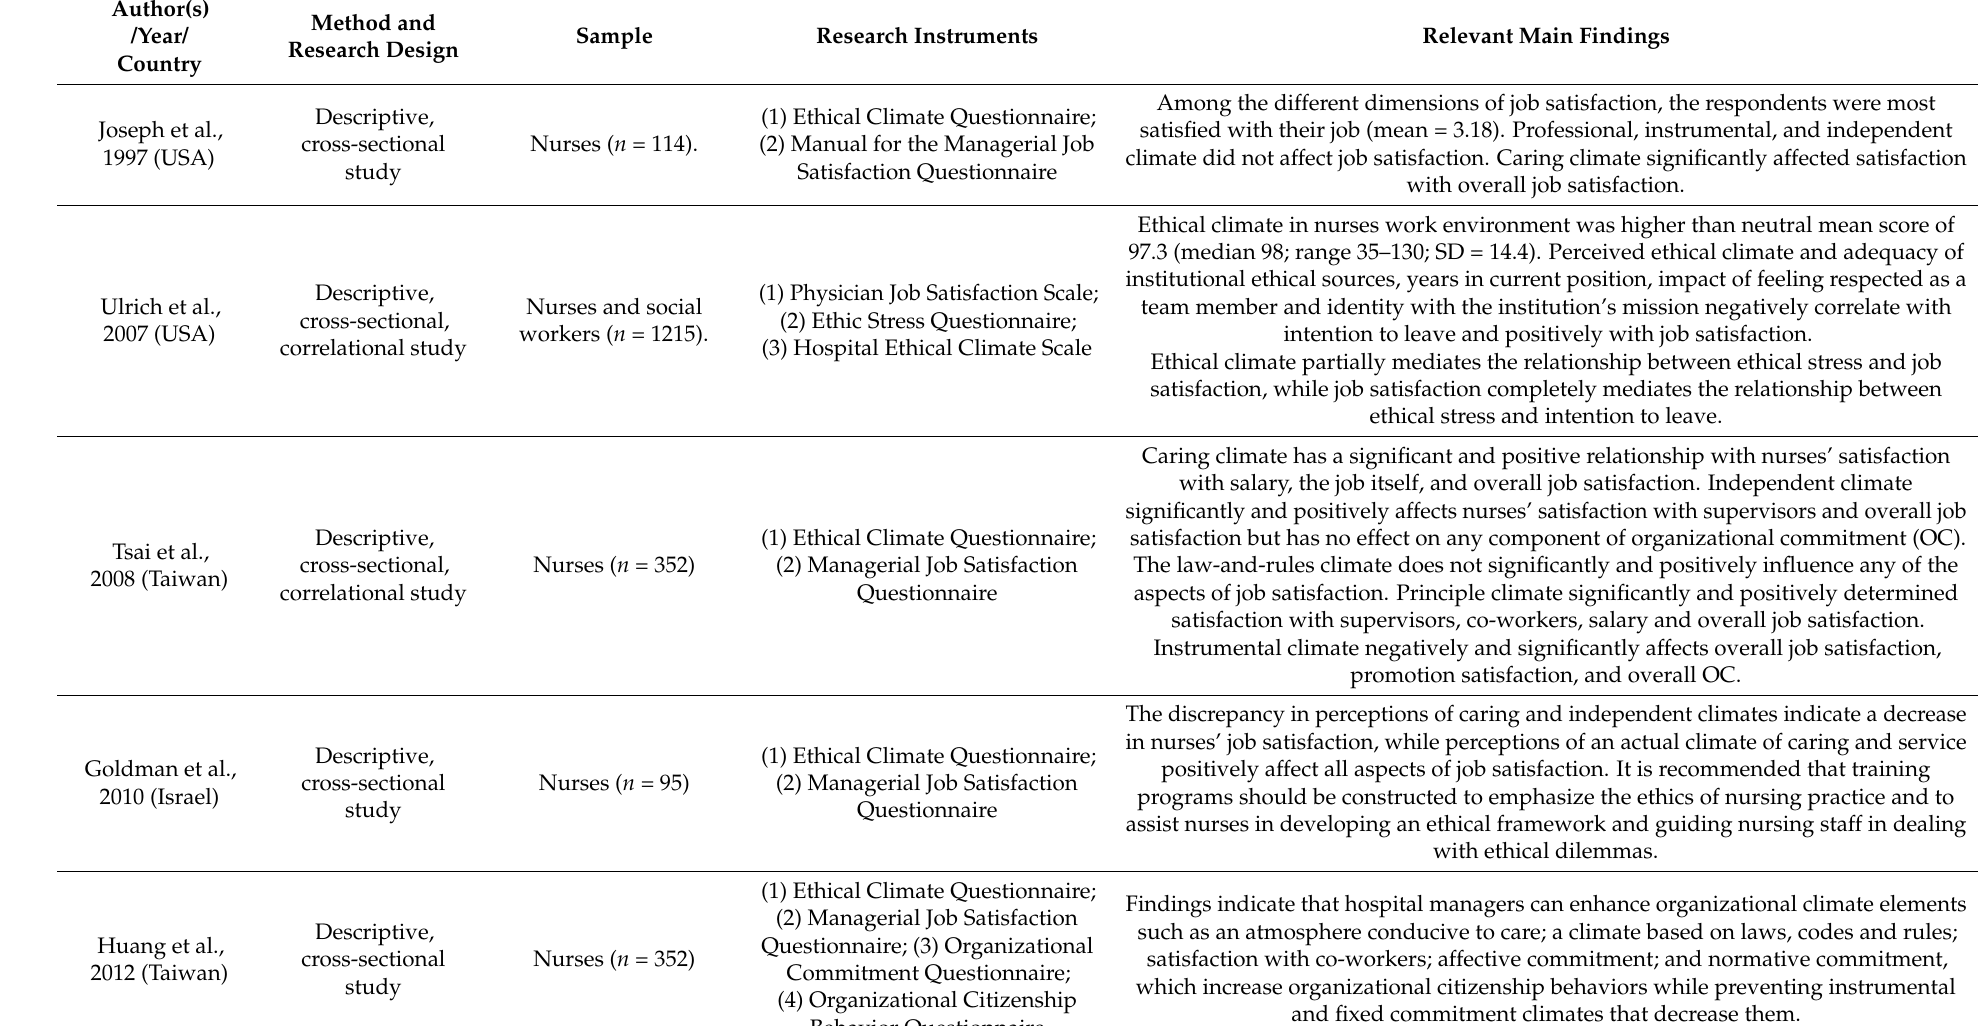
Table 1. Main characteristics of studies